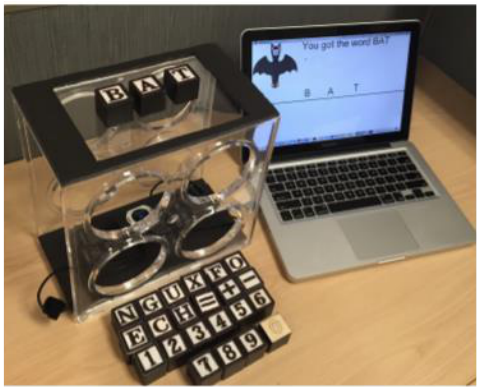
Figure 8. Proposed BlackBlocks with a running example of 3-letter words [20].